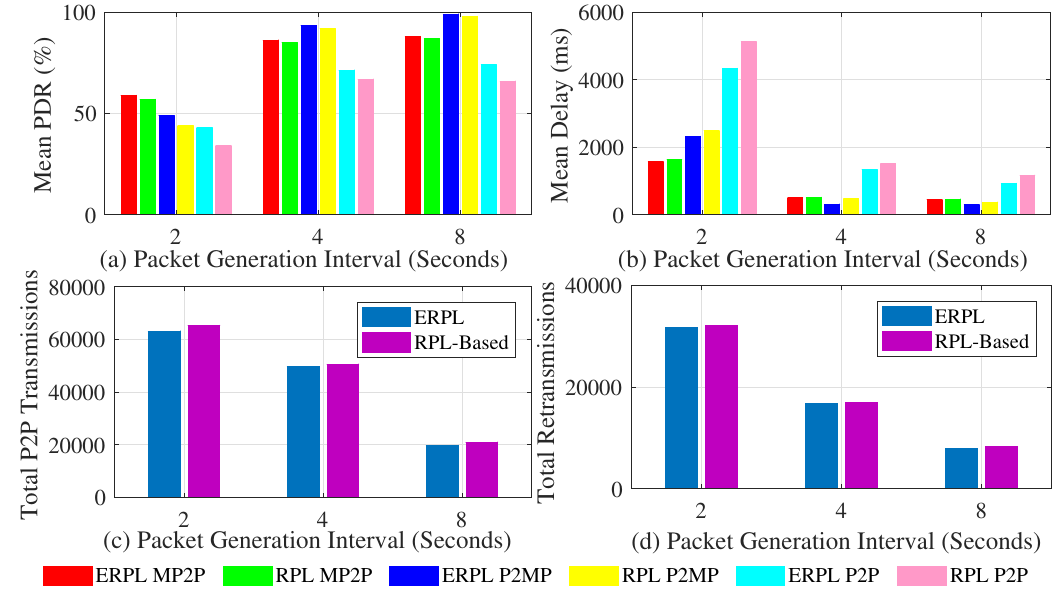
Figure 9. Protocols’ Performances with Grid Topology (Gateway at Network